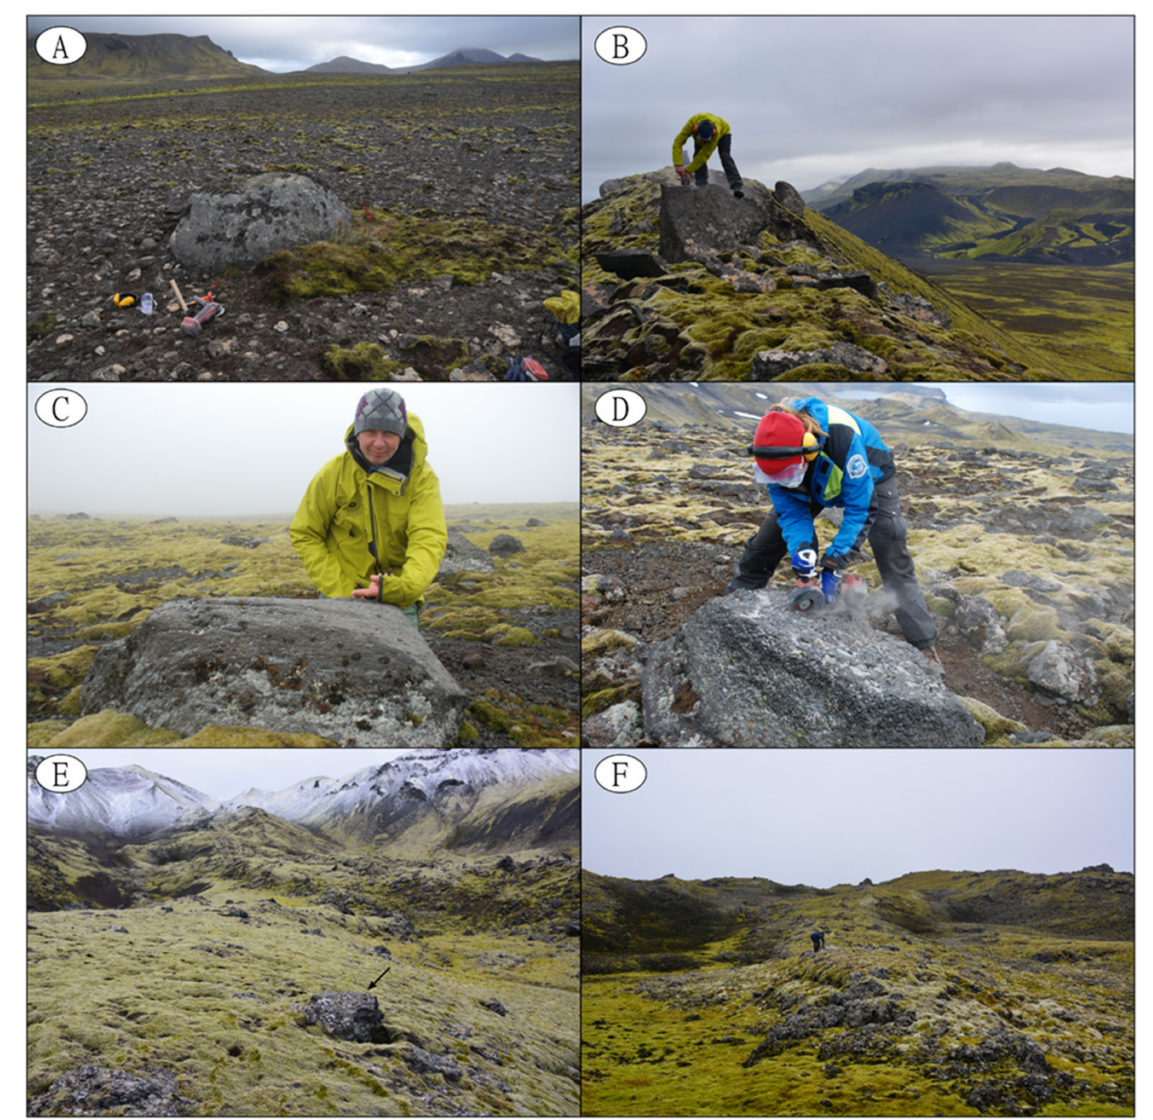
Figure 3. Photographs showing selected sample locations. ( A ) JM2015-11, erratic boulder on till, Midt-Jan. ( B ) JM2018-74, lava, tindar on Sør-Jan. ( C ) JM2015-08, striated erratic boulder on till, Nord-Jan. ( D ) JM2015-01, erratic boulder on Nord-Jan. A battery-powered rock saw was used for sampling. ( E ) JM2018-113, lava flow. ( F ) Thin layer with plant material overlying a lava